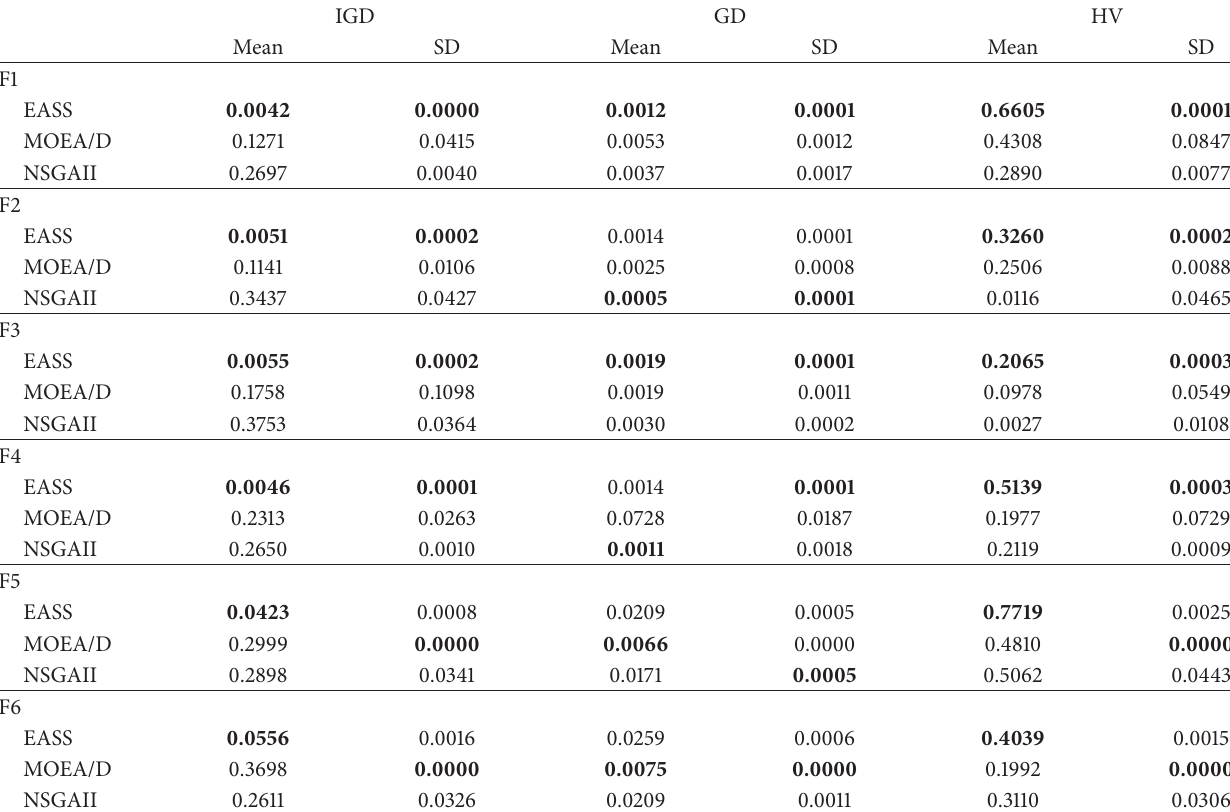
Table 2: IGD, GD, and HV obtained by EASS, MOEA/D, and NSGAII on